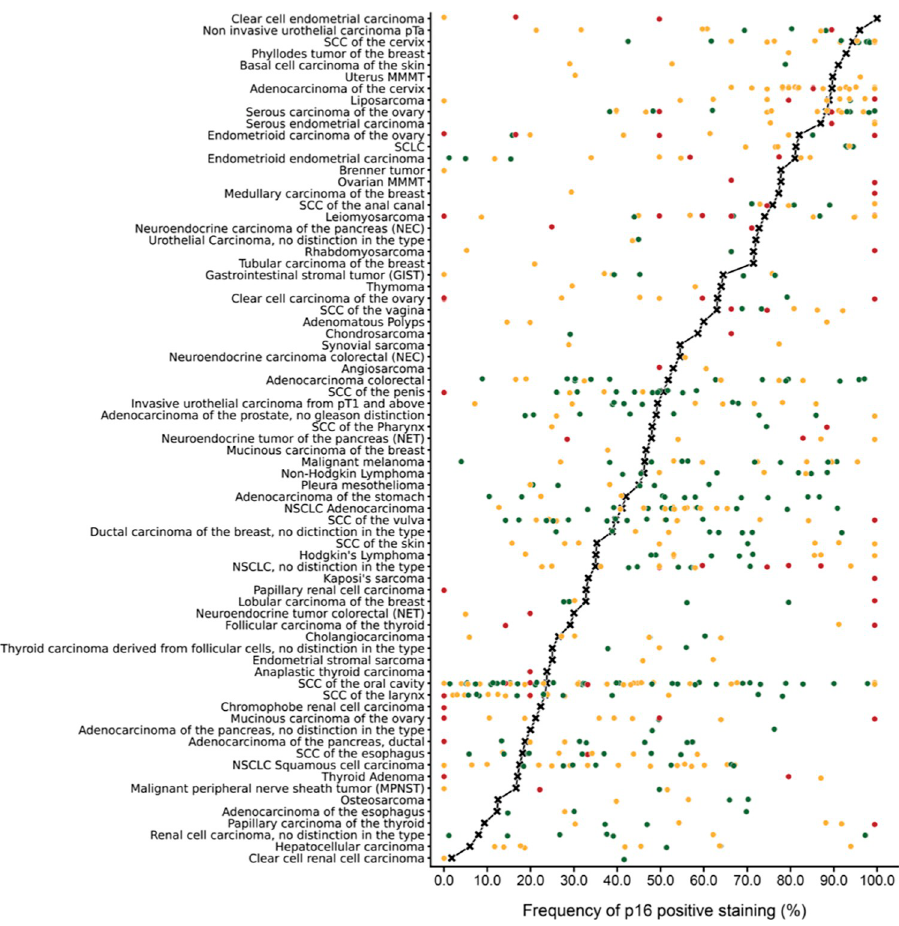
Fig 5. Graphical representation of p16 data from this study (marked with a cross) in comparison with data from existing literature (marked with dots). In order to simplify the figure the percentage of weak, moderate and strong staining was merged. Red dots are used for previous studies involving 1–9 cases, yellow dots for studies involving 10– 50 cases and green dots for studies involving > 50 cases. All studies are quoted in a list of references in S1